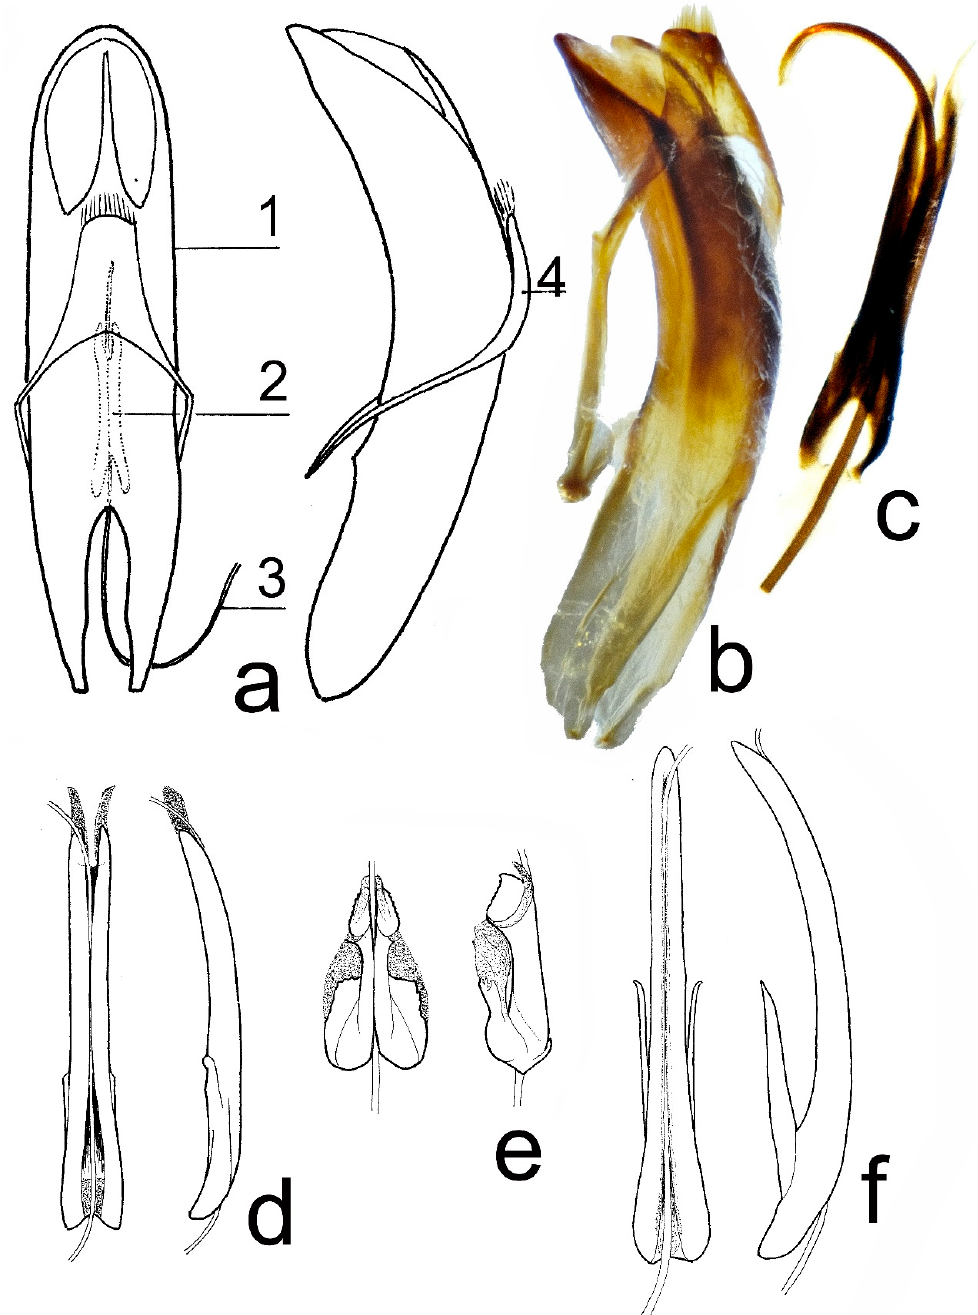
Figure 1. Male genitalia. ( a ) Timarcha hummelii , dorsal, and lateral view: 1—median lobe of aedeagus, 2—manubrium within median lobe, 3—flagellum, 4—tegmen; ( b ) T. hummelii , neotype, ZMMU, median lobe, lateral view; ( c ) T. hummelii , neotype, ZMMU, manubrium, dorsal view; ( d ) T. hummelii , W. Caucasus; ( e ) T. metallica , Tirol; ( f ) T. corinthia , Montenegro; ( d – f ) manubrium and flagellum, dorsal and lateral